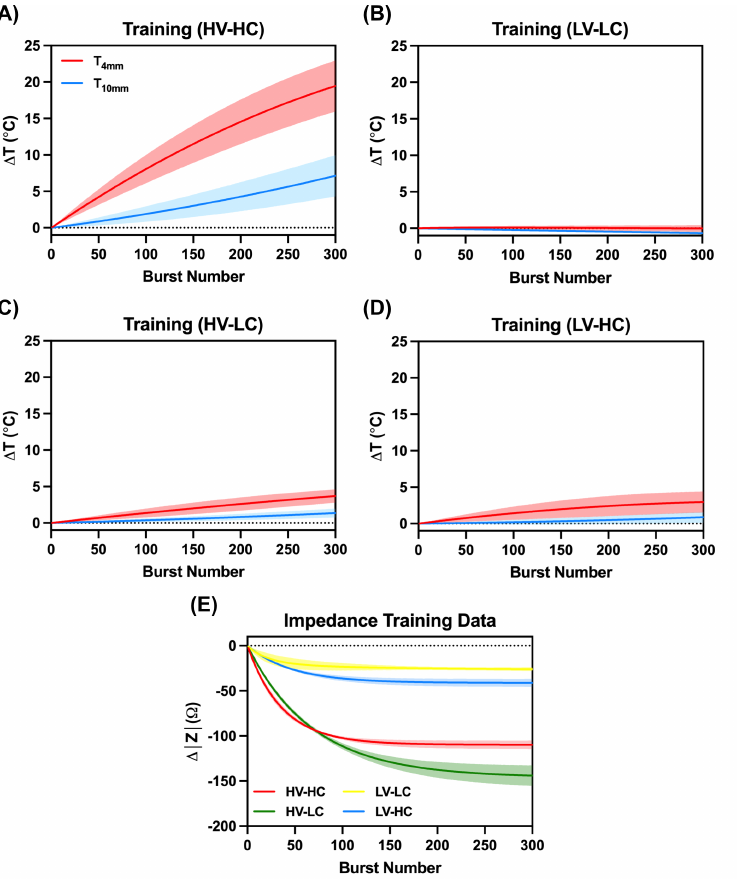
Figure 4. Results of the experimental temperature changes for the ( A ) High Voltage-High Conduc- tivity (HV-HC), ( B ) Low Voltage-Low Conductivity (LV-LC), ( C ) High Voltage-Low Conductivity (HV-LC), and ( D ) Low Voltage-High Conductivity (LV-HC) groups as well as the ( E ) recorded changes in impedance measurements from the agar tissue phantom. Shaded regions relate to standard devia- tions within each